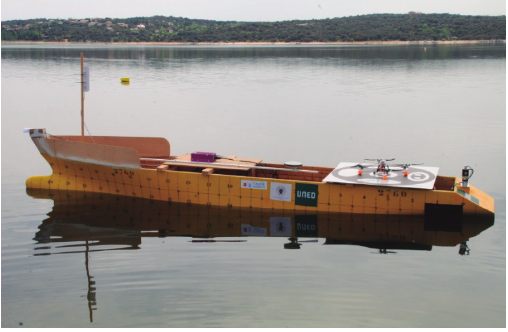
Figure 2. Scale ship used for the